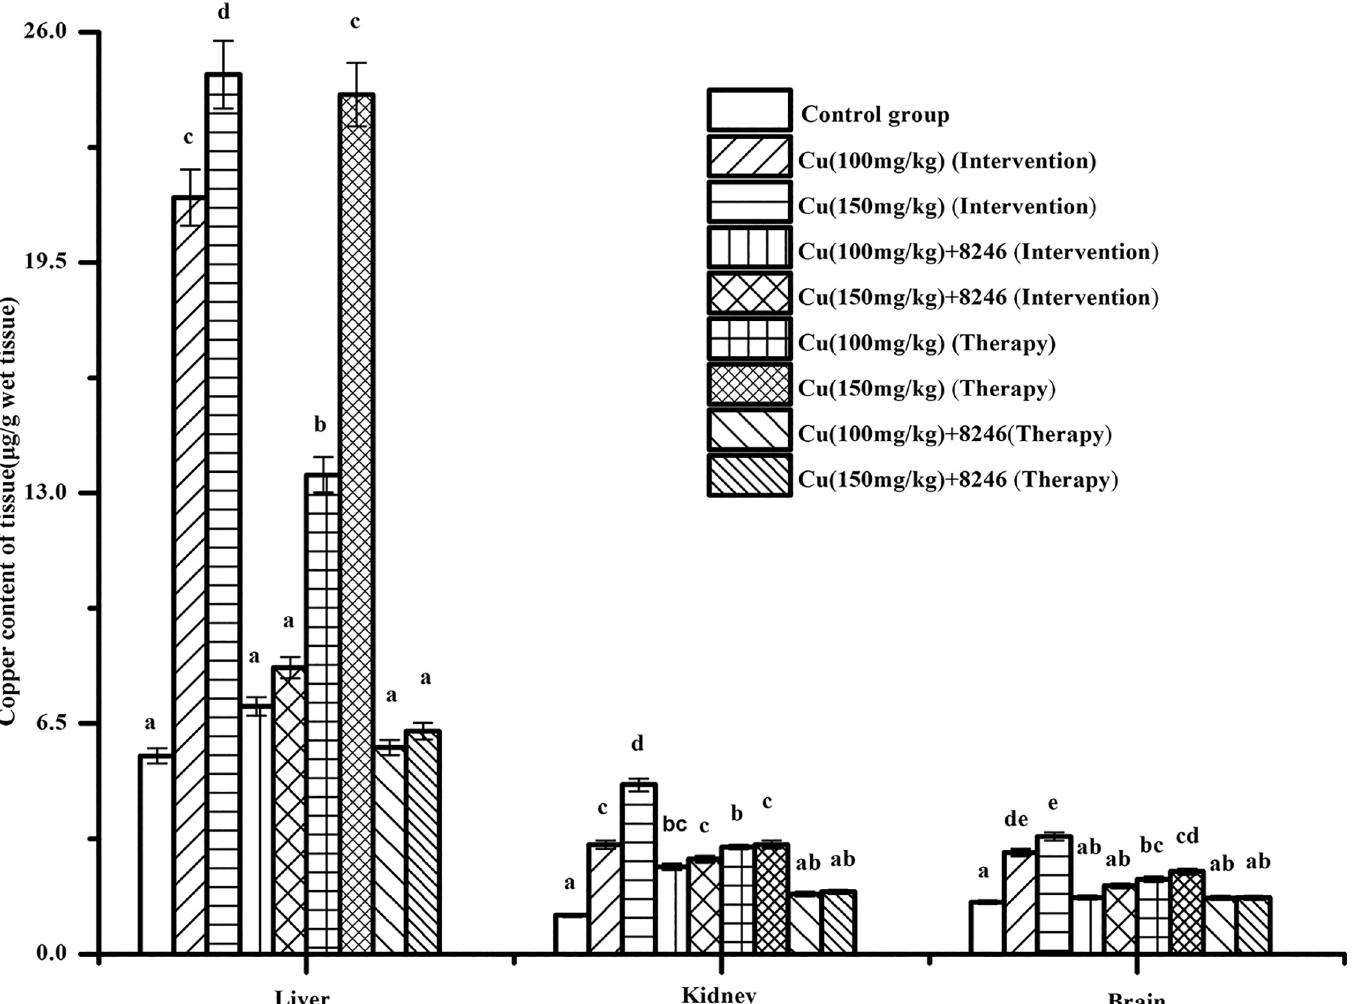
Fig 7. Copper content in livers, kidneys and brains of mice. Values are mean ± SEM with 10 mice in each group. The letters a, b, c, d and e mean that in each tissue, groups with different letters differ significantly ( p <